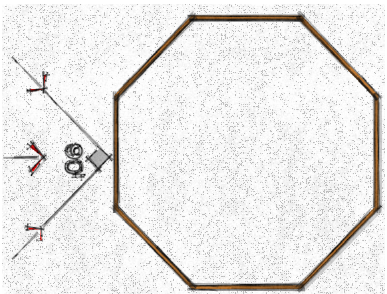
Figure 4. Illustration of camera angles in taking images of each side of the object